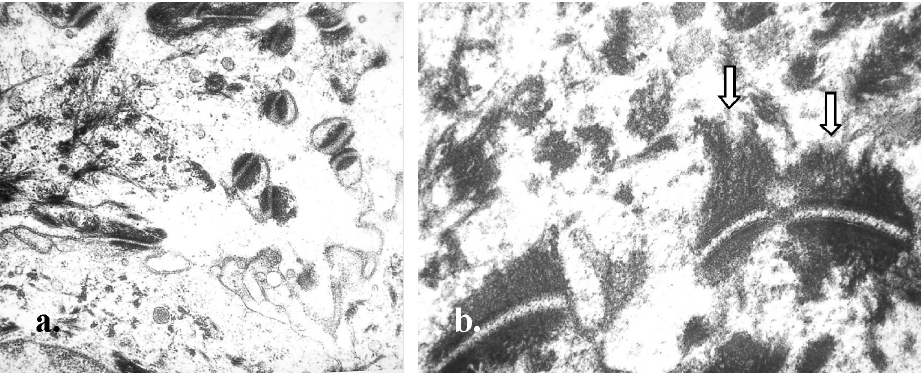
Figure 5 – Two hours after the experiment a. Intercelular vacuolization with free desmosomes (x 25.000). b. granular degeneration of keratin filaments (arrows), which lost its typical filamentous aspect (x